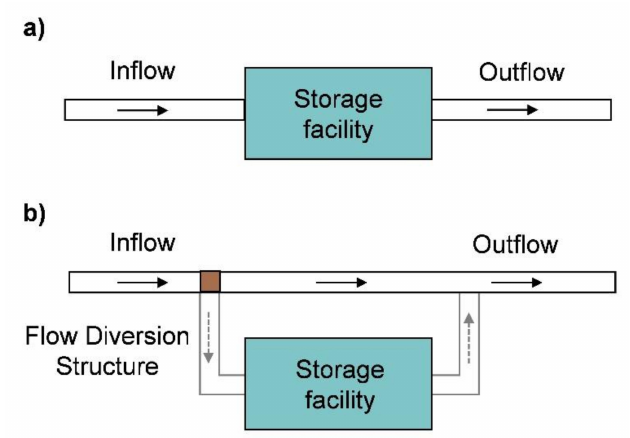
Figure 3. Examples of in-line structure of a detention basin ( a ) and an off-line detention basin ( b